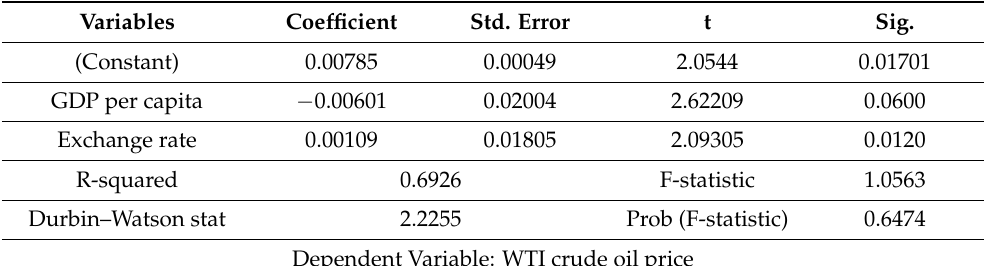
Table 7. The Results of OLS Regression Analysis for Analyzing the Impact of WTI Crude Oil Price and National Income during from 1990 to 2020.